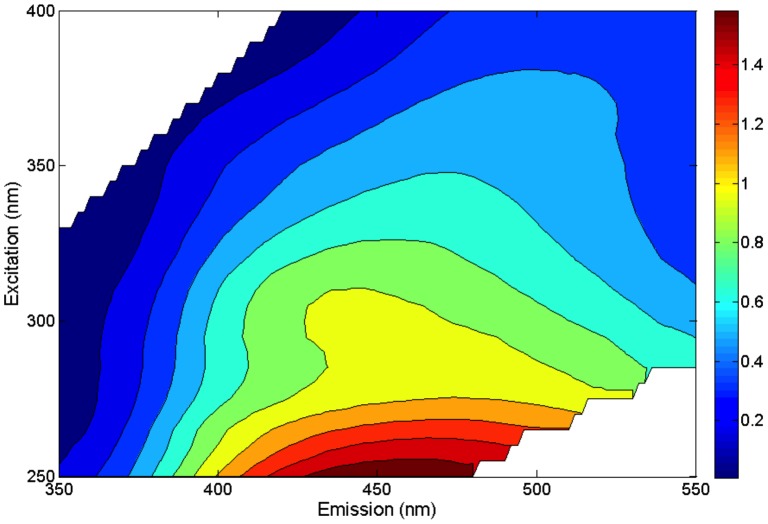
Heat map of Super Hume chemistry.The heat map represents the excitation-emission matrix spectra (EEMs) from a 3D fluorescence scan of Super Hume that was used in parallel factor analysis (PARAFAC).